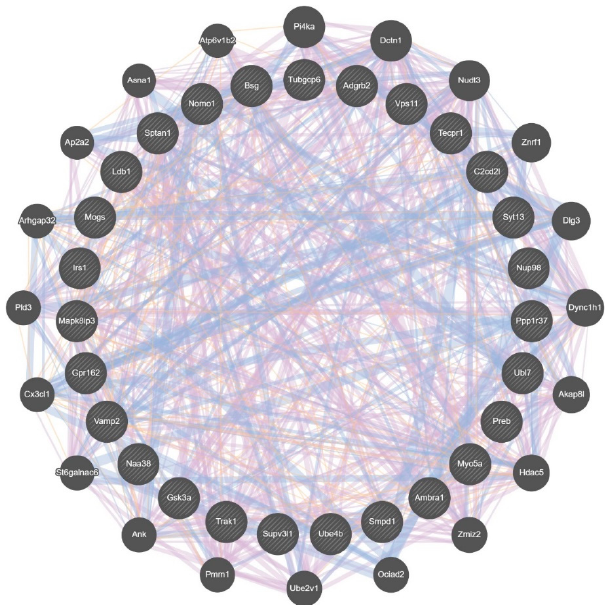
Figure 6. Composite gene-gene functional interaction network for differential splicing in the ventral midbrain (VMB), associated with relative genetic risk for methamphetamine (MA) intake. This network was derived from the 27 hub nodes (inner circle; symbol size has no meaning) in the MA low drinking (MALDR) line that had an increase of ≥ 0.5 in intramodular connectivity. No such genes were found in the MA high drinking (MAHDR) line. The genes in the outer circle were identified by GeneMANIA [34] as functional associates (symbol size determined by GeneMANIA, based on number of network connections). The pink lines indicate known coexpression (81%), the blue indicate known colocalization (18.5%), and the tan are predicted interactions (0.5%); these can be more clearly seen in supplementary Figures S1–S3.